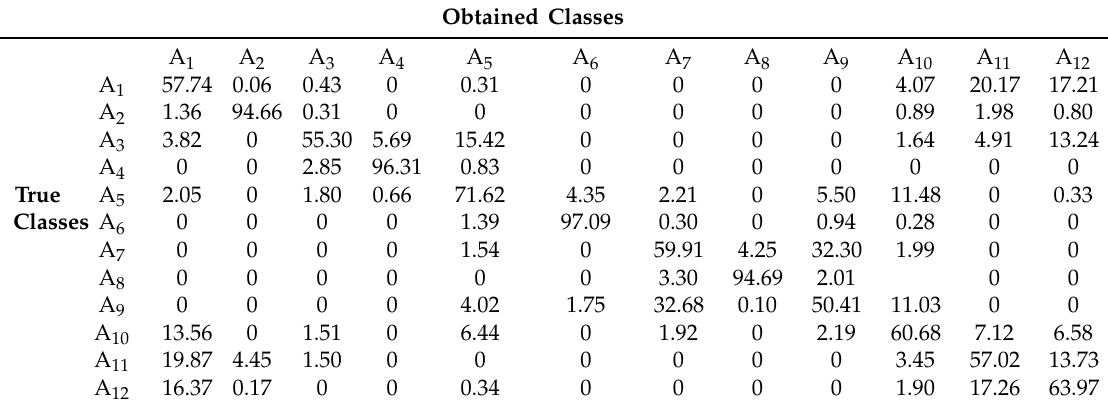
Table 10. Global confusion matrix obtained with HMM using selected